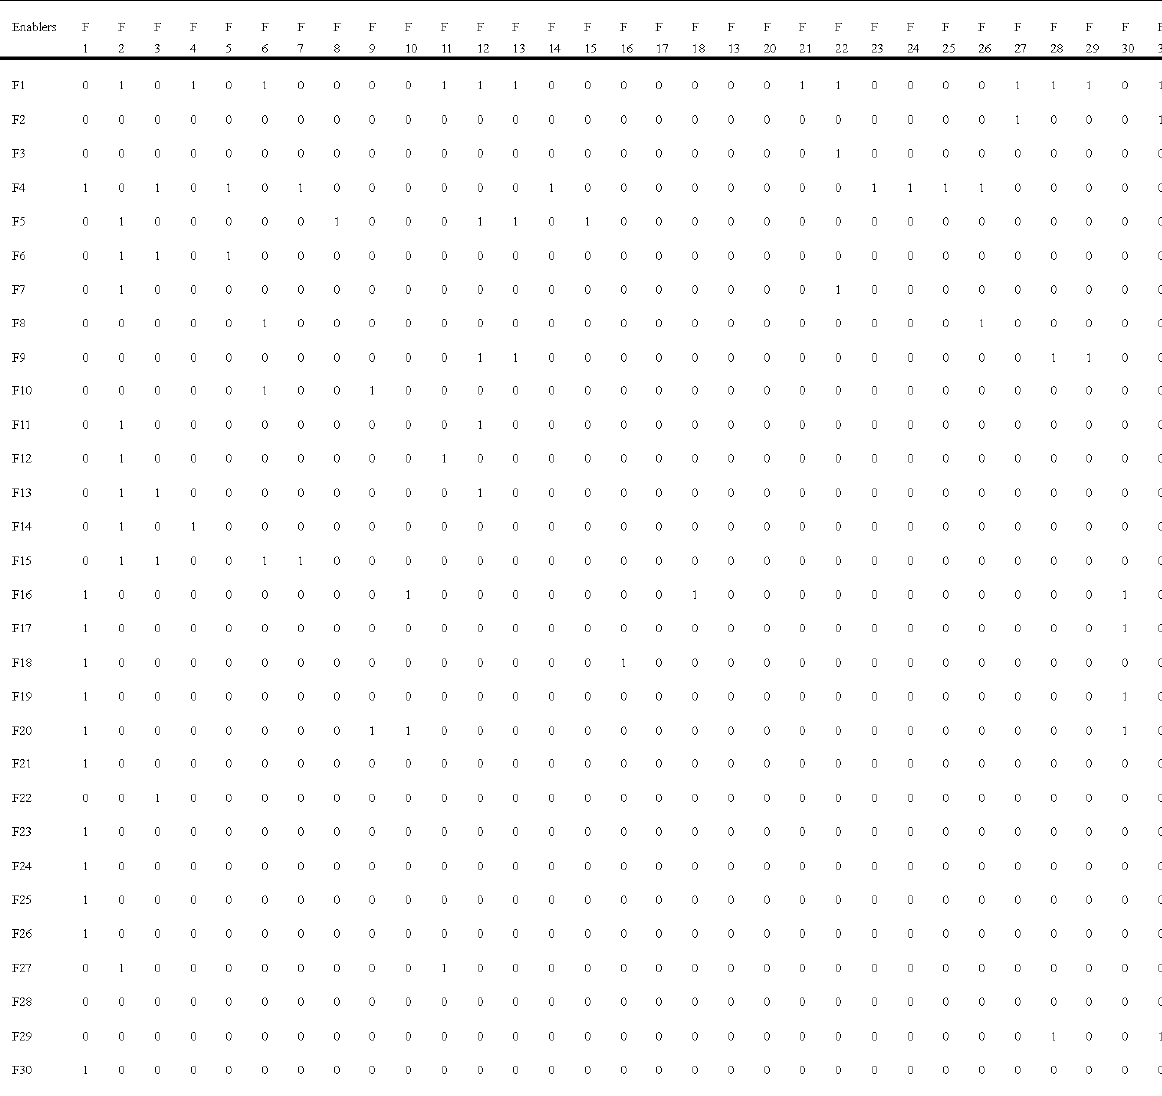
Figure A1. Note: See Table 2 for enabler names. Figure A1. Adjacency matrix for the enablers. Note: See Table 2 for enabler